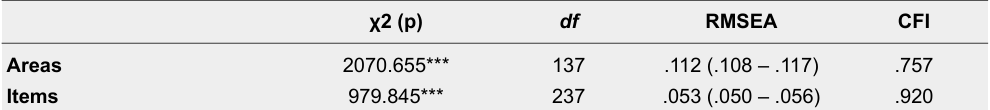
RIASEC Six-Factor Fit Indexes for CFA Models Tested with Maximum Likelihood (N = 1117)